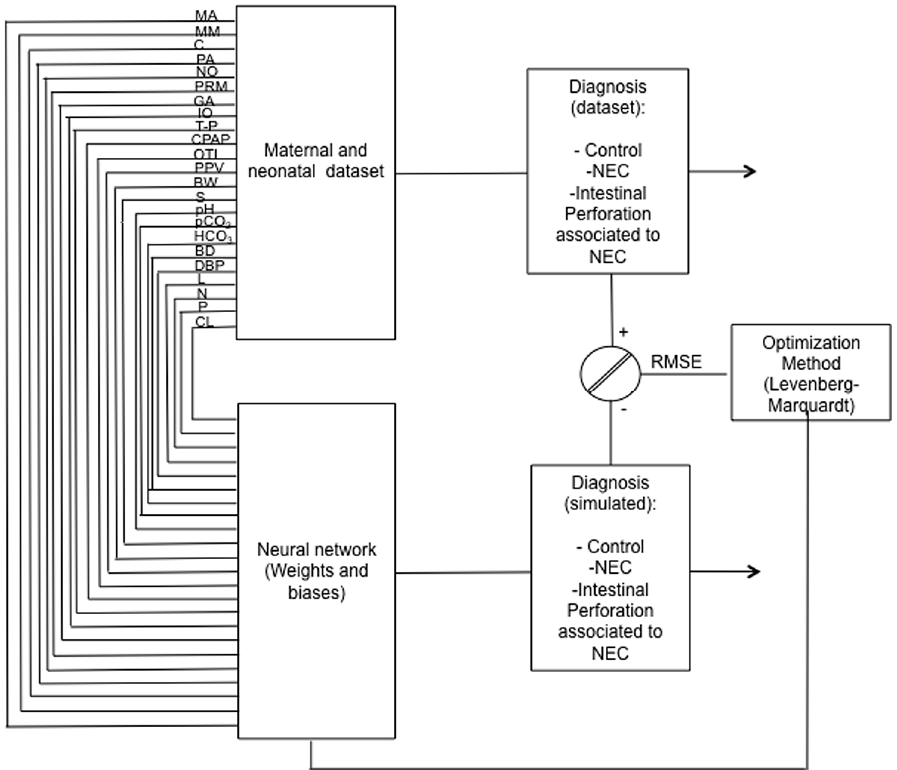
Figure 1. A representative network architecture of Intestinal perforation (IP) model. The learning procedure used by ANN for the estimation of IP associated with NEC from 23 maternal and neonatal variables at birth (maternal age, maternal morbidity, chorioamnionitis, prenatal antibiotic, number of offsprings, premature rupture of membranes, gestational age, oxygen therapy (indirect oxygen, T-piece, continuous positive airway pressure, positive pressure ventilation cycles, orotracheal intubation), birth weight, sex, arterial pH, blood gas (CO 2 , HCO 3 , base deficit), diastolic arterial blood pressure, number of total leukocytes, neutrophils, platelets and catheter location), trained by the Levenberg-Marquardt optimization algorithm. The same architecture was used for IP estimation with birth and hospitalization variables.